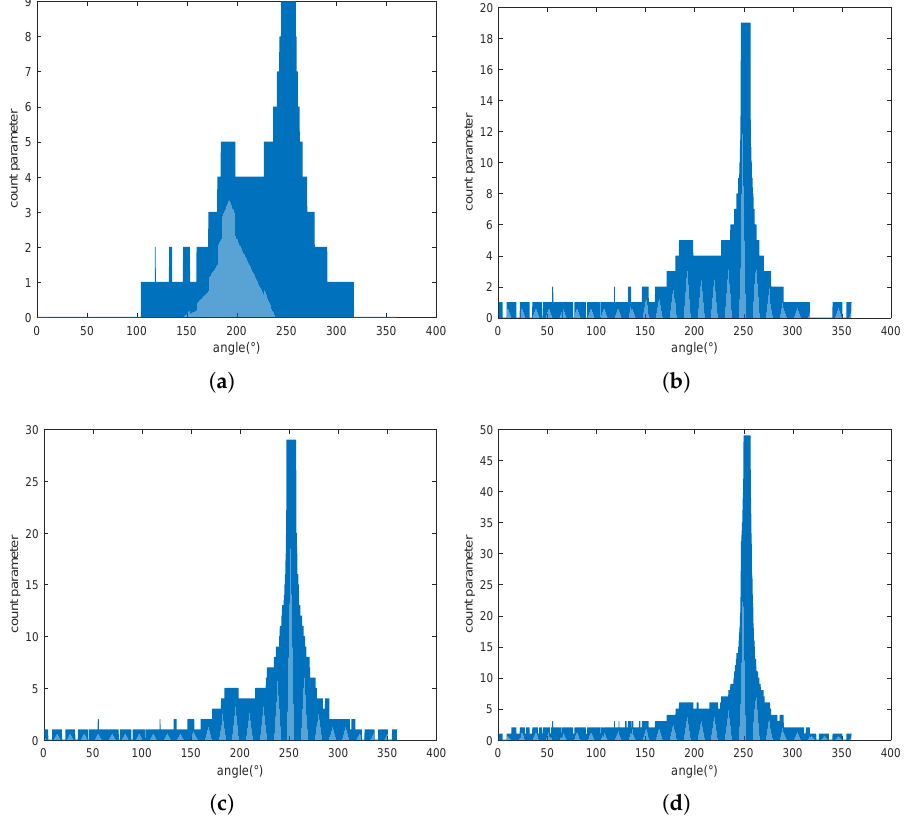
Figure 8. Performance analyzing of different calculation times. ( a ) Calculation times = 10. ( b ) Calcu- lation times = 20. ( c ) Calculation times = 30. ( d ) Calculation times = 50. Table 2. Simulation results of different calculation